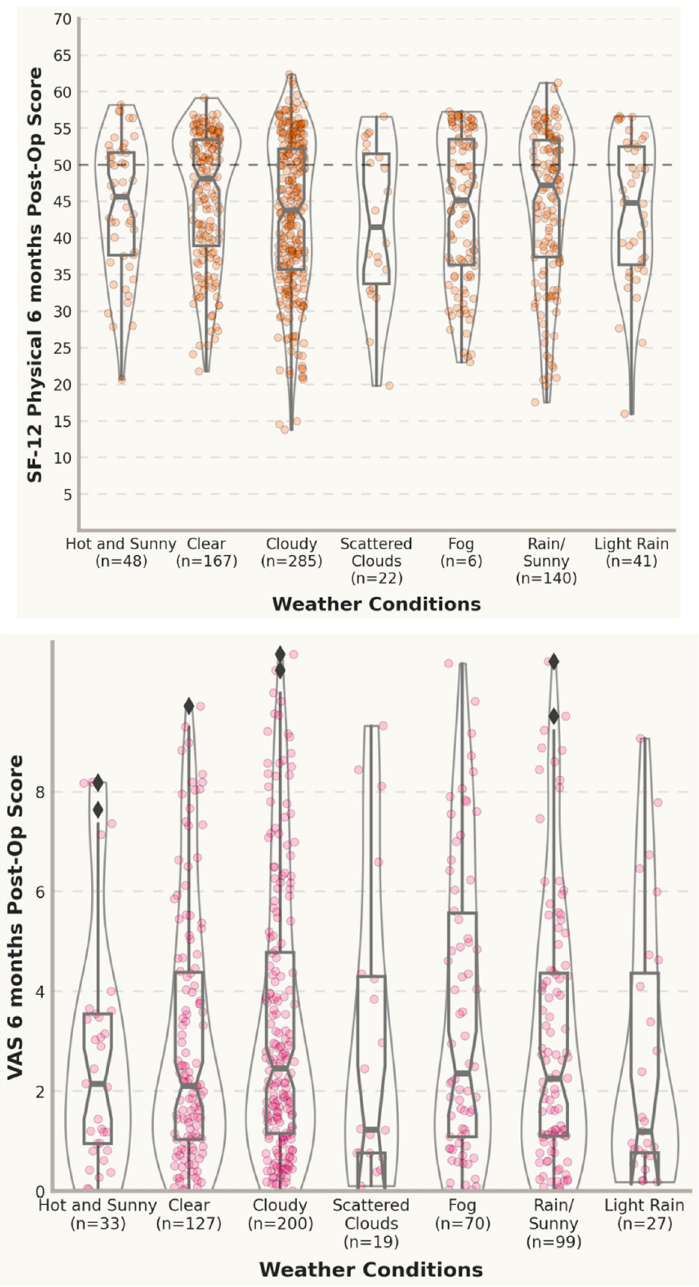
Figure 6. Post-operative scores under different weather conditions (6 months). Standardized scoring 50 ± 10 (mean ± SD) [34,35].